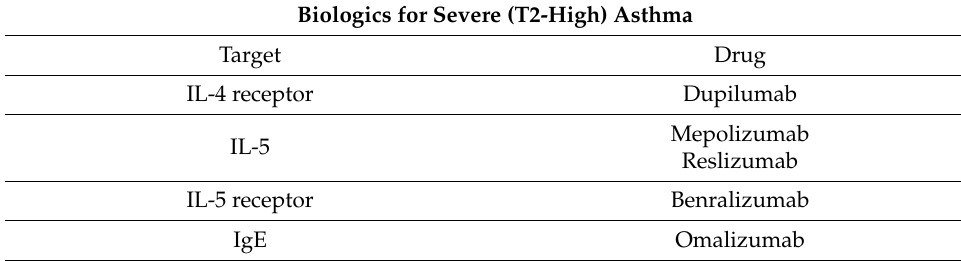
Table 3. Biological severe asthma